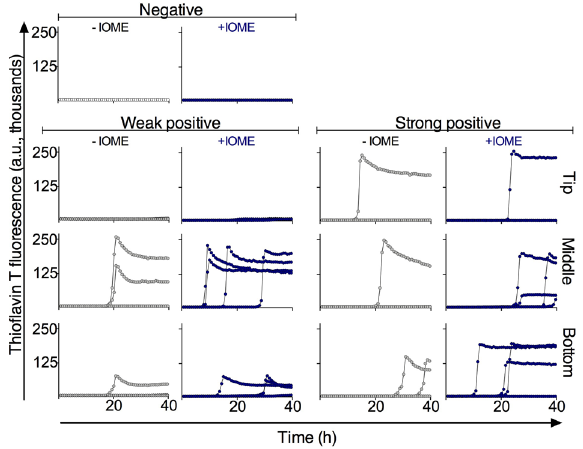
Figure 3. Fluorescence traces from individual wells (n = 4 per sample) of RT-QuIC reactions seeded with homogenates of ear punches collected from different regions of pinna apex (above the dashed line in Fig. 2). The RT-QuIC reactions (without IOME extraction, − IOME) were seeded with 10 –2 dilution of ear homogenate in 0.1% SDS/PBS/N2. For the IOME-RT-QuIC reactions, a 1:10 dilution of iron oxide magnetic beads in 0.1% SDS/PBS/N2 was prepared, and the reactions were seeded with ear tissue equivalents comparable to the 10 –2 dilution used in the reactions without IOME. ‘Weak positive’ and ‘strong positive’ labels refer to the ELISA positivity of RLN tissue from the same deer.